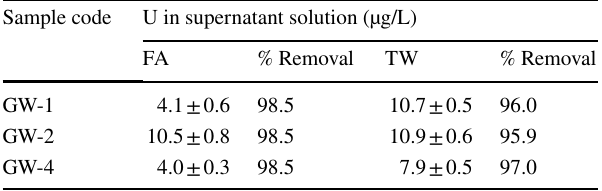
Table 6 Application of adsorbents for U removal from spiked